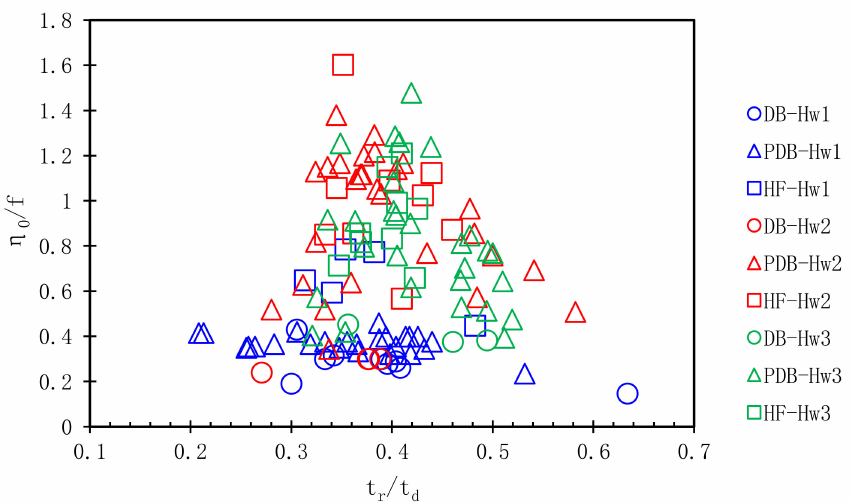
Figure 11. Relation between the nondimensional maximum freeboard exceedance ( η 0 / f , where f is the initial freeboard, 0.05 m) and the t r /t d ratio (where t r and t d are rise and event duration times, respectively) for all the events of the 15 study